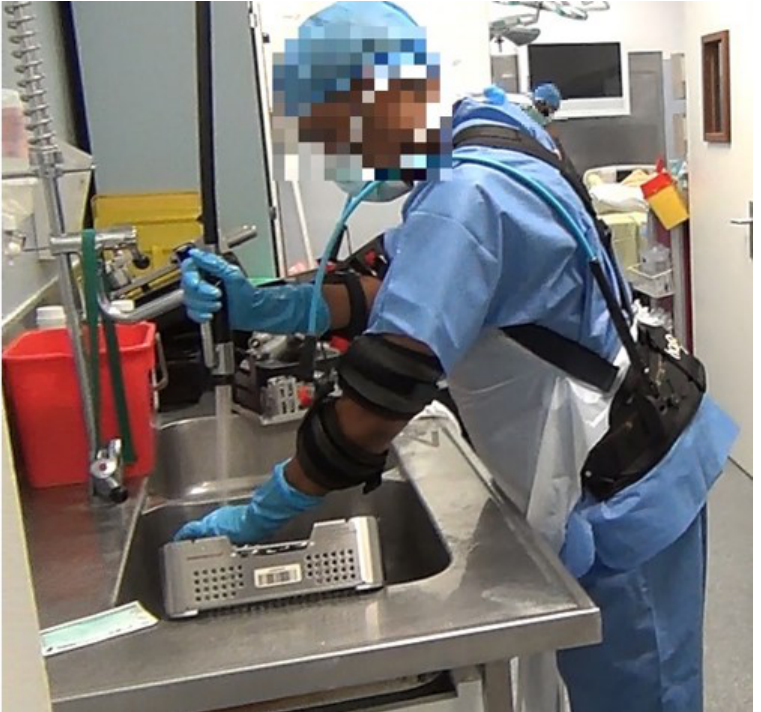
Figure 2. Healthcare worker wearing the exoskeleton during the task of cleaning surgical